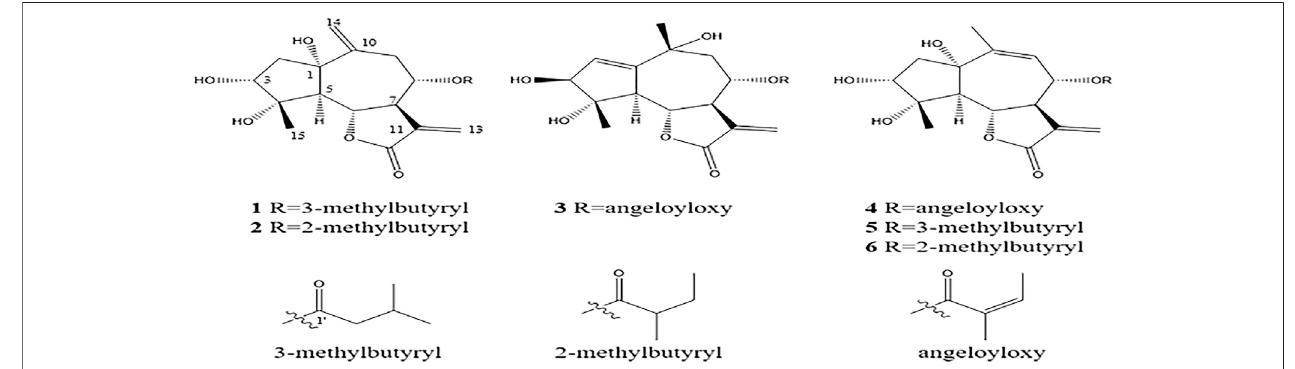
FIGURE 2 | Structures of compounds one to six isolated from A. argyi .